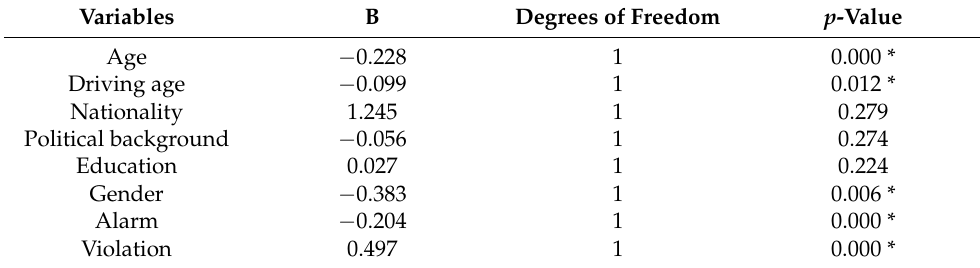
Table 13. Score test